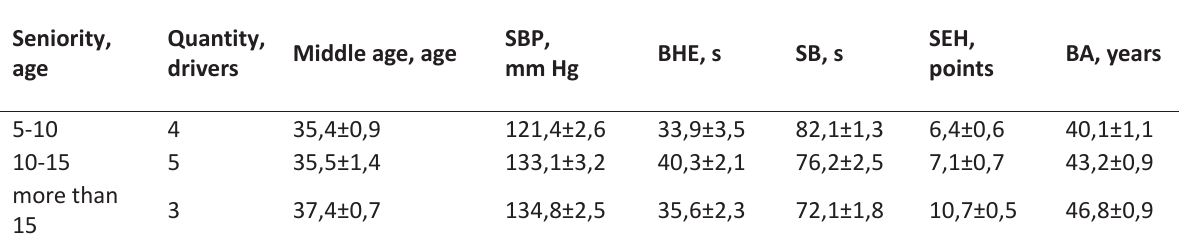
Table 4. Indicators of basic physiological tests in drivers